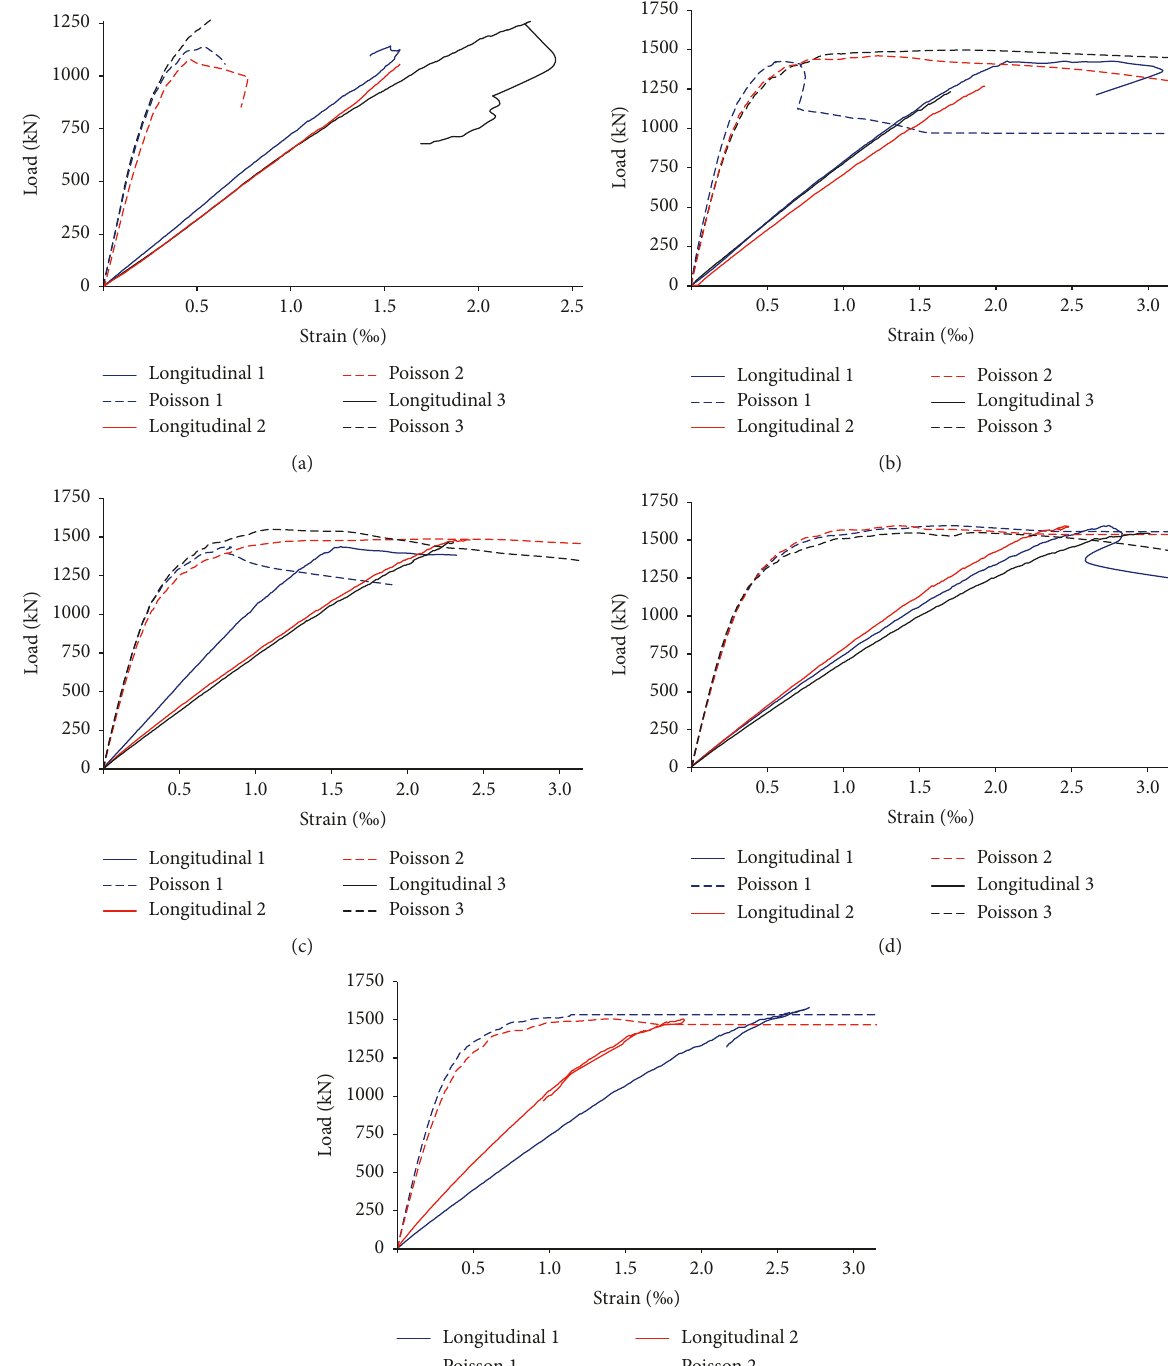
Figure 5: Load-strain diagrams for HSC with different FWRs. (a) FWR (e) FWR 60kg/m 3 (cid:31)